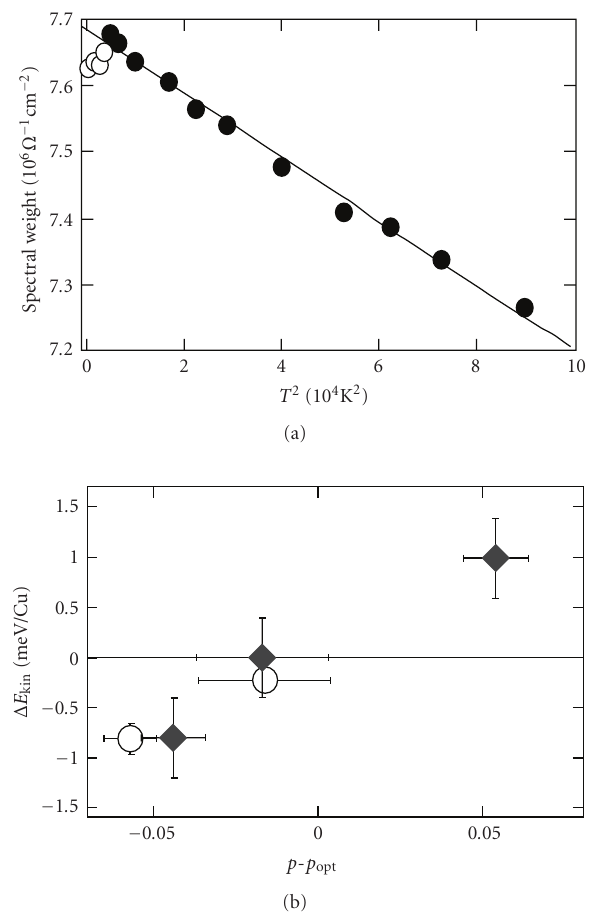
Figure 10: (a) Spectral weight W n ( Ω c , T ) of the overdoped Bi 2212 for Ω c = 1eV. Closed symbols—normal state. Open symbols— superconducting state. (b) Change of the kinetic energy Δ E kin = E kin, S − E kin, N in meV per Cu site versus the charge p per Cu with respect to the optimal value p opt . From